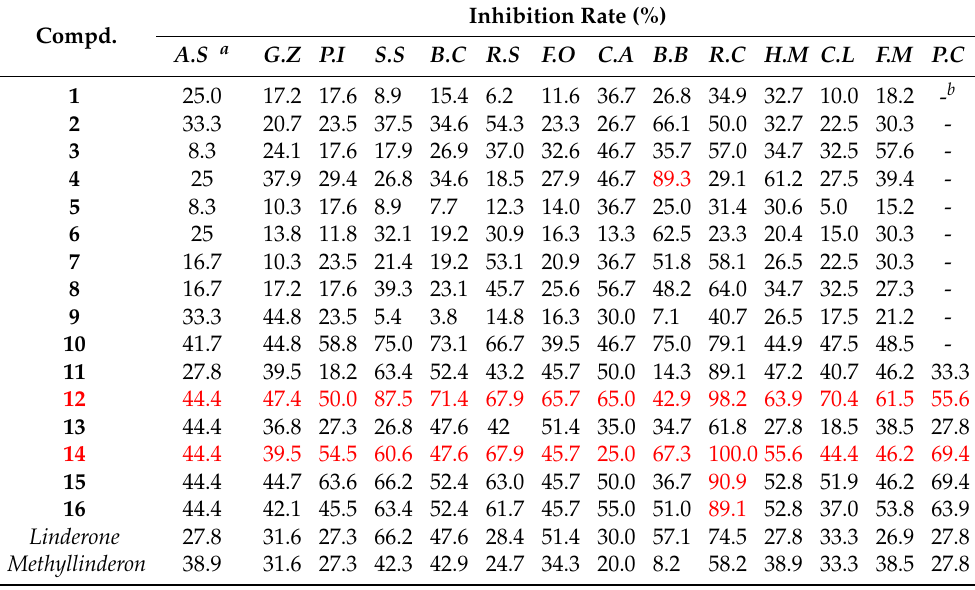
Table 2. Fungicidal activity of title compounds 1 – 16 and Linderone , Methyllinderone at 50 µ g · mL − 1 .